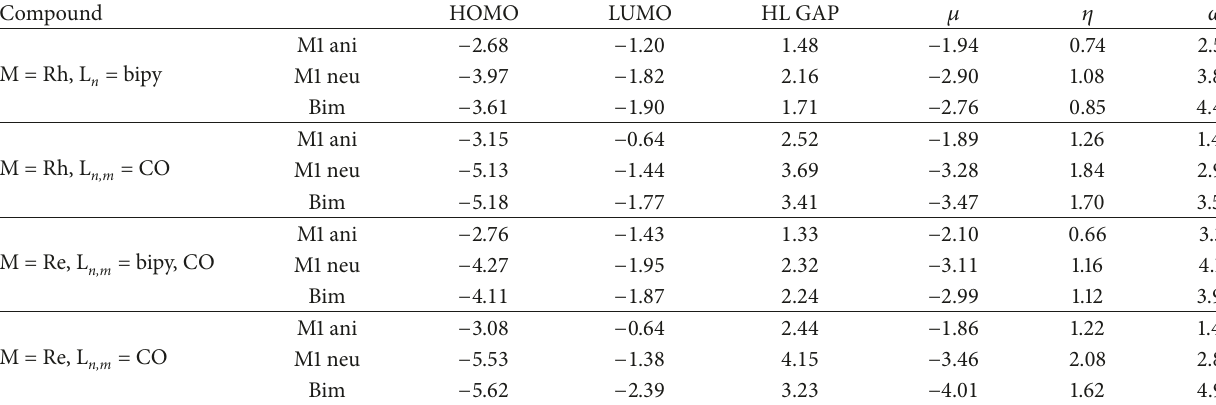
Table 3: Estimated energies for the HOMO and LUMO, chemical potential ( 𝜇 ), chemical hardness ( 𝜂 ), and electrophilicity ( 𝜔 ) calculated for the optimized ground state minima of the metallic